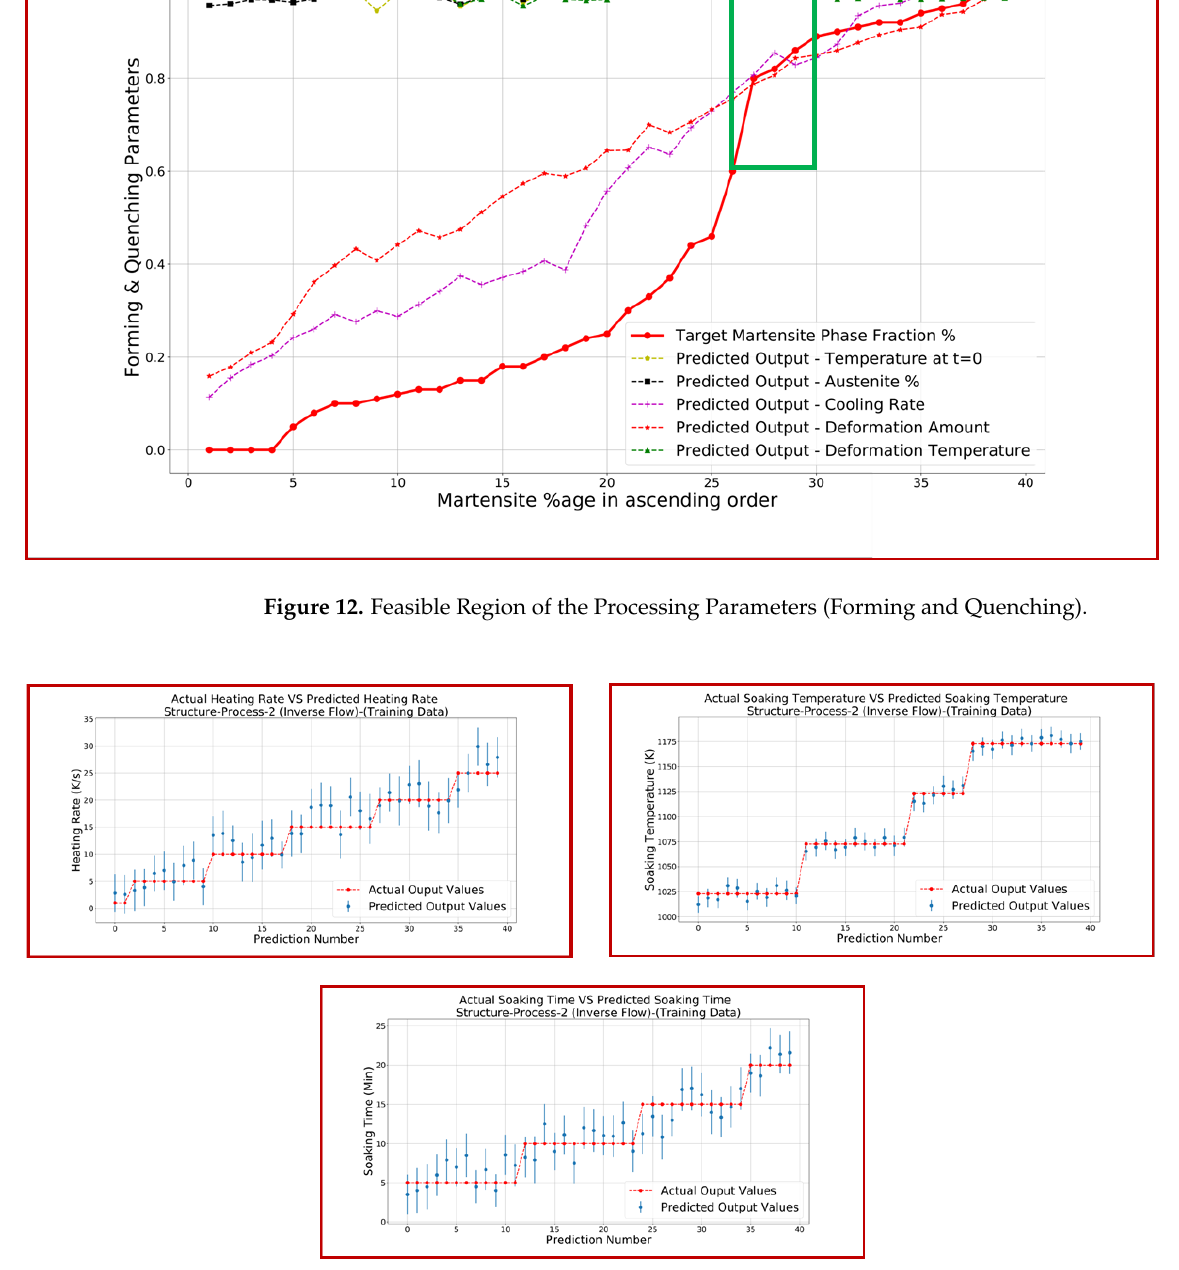
Figure 13. Predicted Output and Actual Output Comparison for Step 3.2 (for Input Dataset).